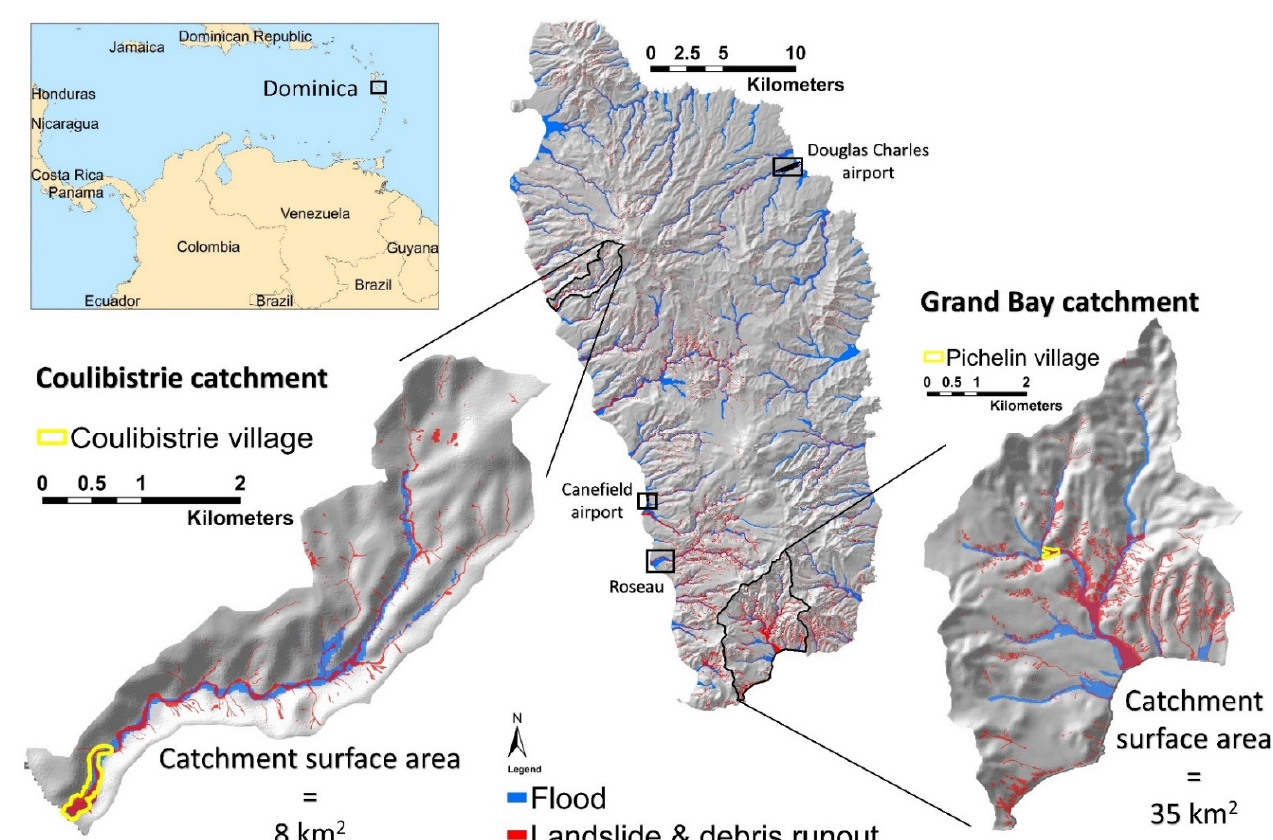
Figure 1. Location of study areas (Coulibistrie and Pichelin) shown on a hill-shading map of Dominica. Floods are indicated in blue; landslides and runouts are indicated in red. The enlarged images are the hill-shading maps of the two catchments overlaid by floods and landslides and debris runout. The floods are simulated on a 20 m resolution, while the landslides and debris flows are derived from satellite image interpretation (see Charim.net). Table 1. Post hurricane Maria damage, losses, and recovery needs (as of 3 November 2018).